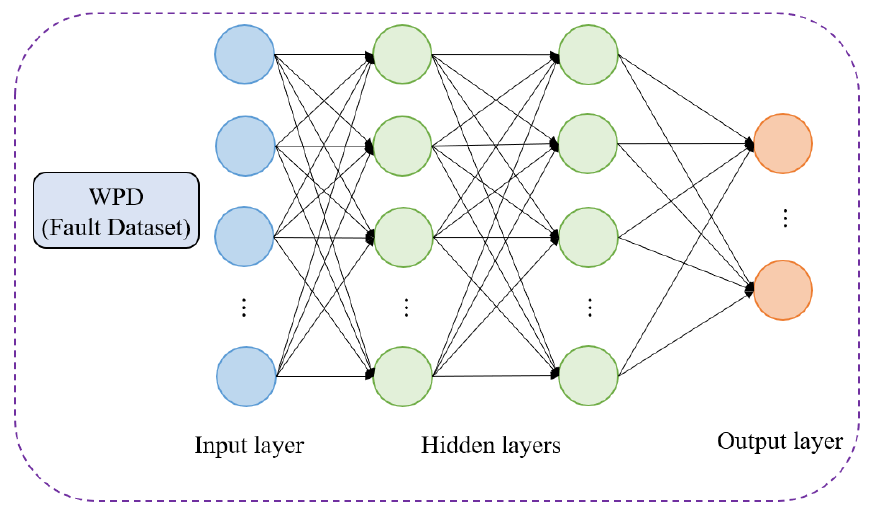
Figure 5. The neural network based on WPD.